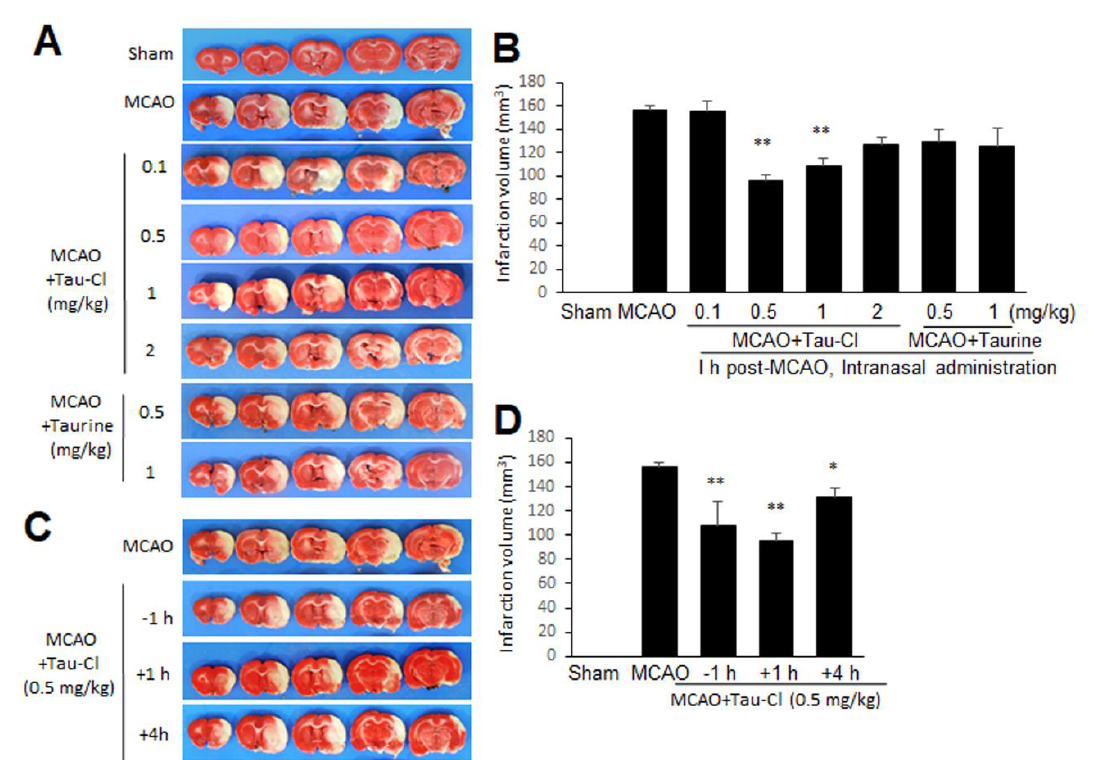
Figure 1. Tau-Cl suppressed infarct formation in the postischemic brain. ( A , B ) Tau-Cl (0.1, 0.5, 1 or 2 mg/kg) or taurine (0.5 or 1 mg/kg) was administered intranasally at 1 h post- middle cerebral artery occlusion (MCAO) and 2,3,5-triphenyl tetrazolium chloride (TTC) staining was carried out at 2 days post-MCAO. ( C , D ) Tau-Cl (0.5 mg/kg) was administered intranasally at 1 h prior to or 1 or 4 h post-MCAO, and TTC staining was carried out at 2 days post-MCAO. Representative images of infarctions are shown ( A , C ), and mean infarction volumes are presented as mean ± SEM (n = 4–10) ( B , D ). Sham, sham-operated rats (n = 4); MCAO, PBS-treated MCAO control (n = 10); MCAO + Tau-Cl, Tau-Cl-treated MCAO rats (n = 33); MCAO + Taurine, taurine-treated MCAO rats (n = 8). * p < 0.05, ** p < 0.01 vs. PBS-treated MCAO control by one-way ANOVA with Student–Newman–Keuls test.